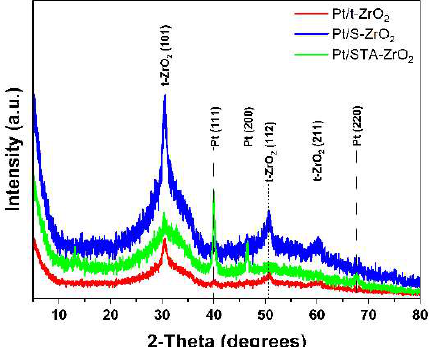
Figure 1. XRD patterns recorded for Pt immobilized functionalized zirconia